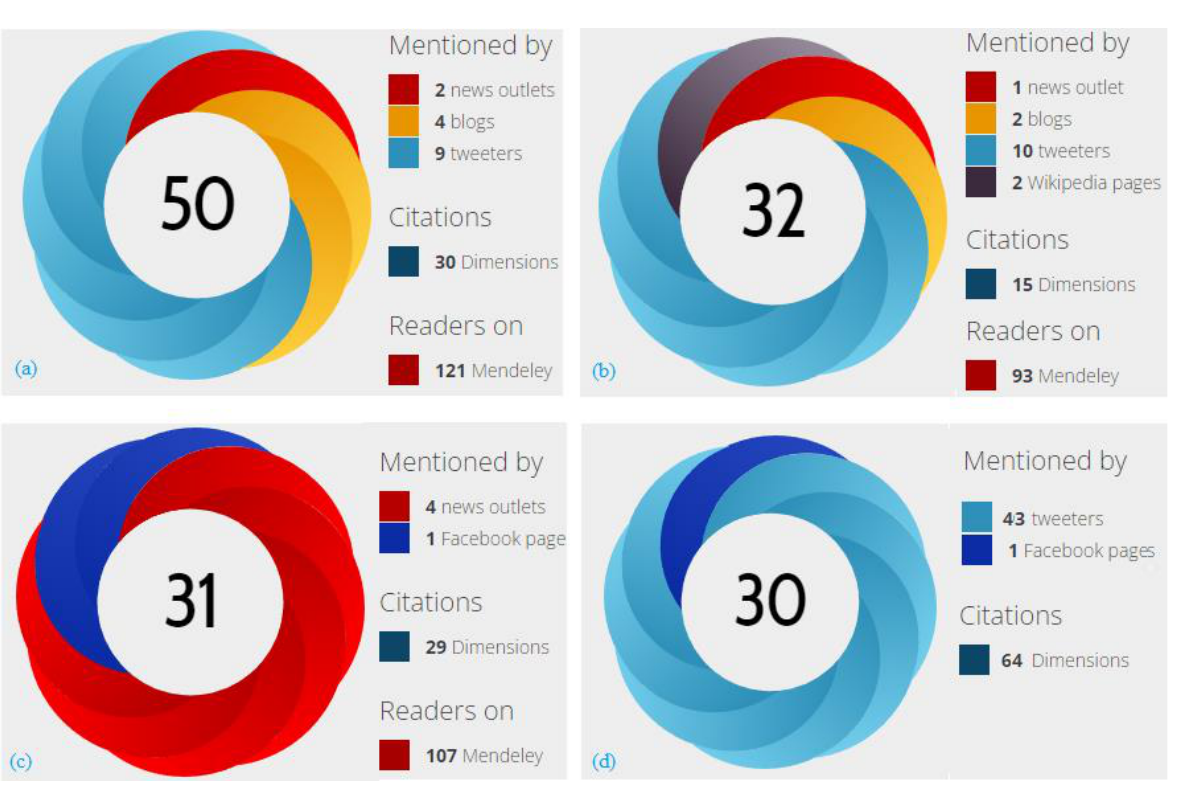
Figure 4. ( a – d ) Publication donuts showing the altmetric scores based on mentions, citations and readers for top 4 publications on environmental valuation.